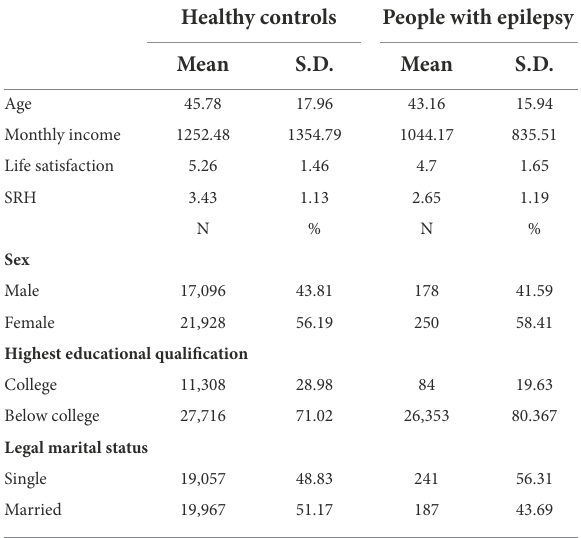
TABLE 1 Descriptive statistics of demographic characteristics, life satisfaction, and SRH in healthy controls and people with epilepsy. Healthy